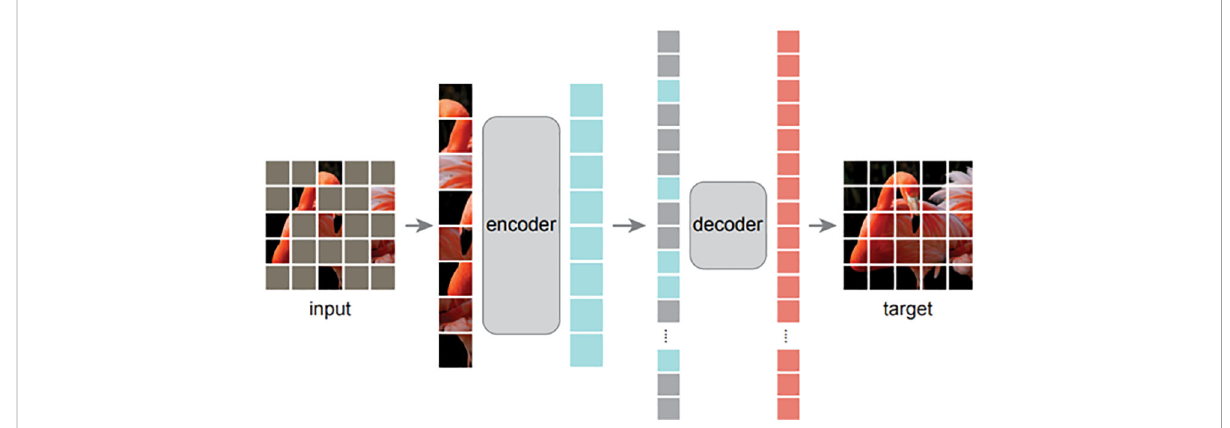
FIGURE 6 The high-level architecture of MAE [13]. With MAE, an image is split into patches that are then randomly blocked. The unblocked patches are fed to an encoder, followed by a decoder to reconstruct the whole input image. After the unsupervised pre-training, the decoder is discarded and only the encoder is utilized in the downstream task. The input is not blocked and a speci fi c classi fi er is added after the encoder when fi ne- tuning the model in a target